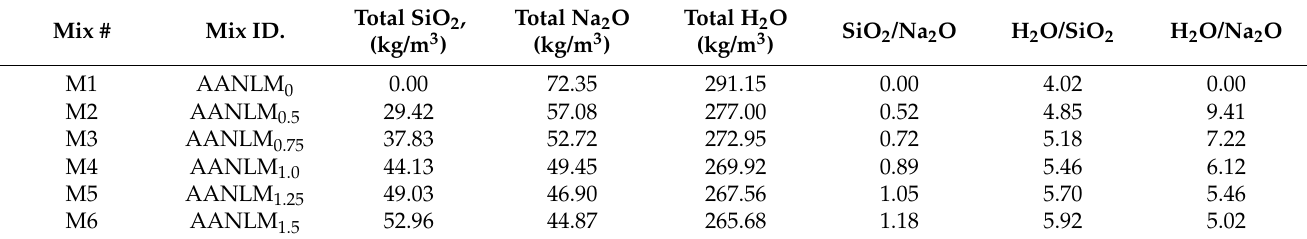
Table 4. Initial oxide composition of the alkaline